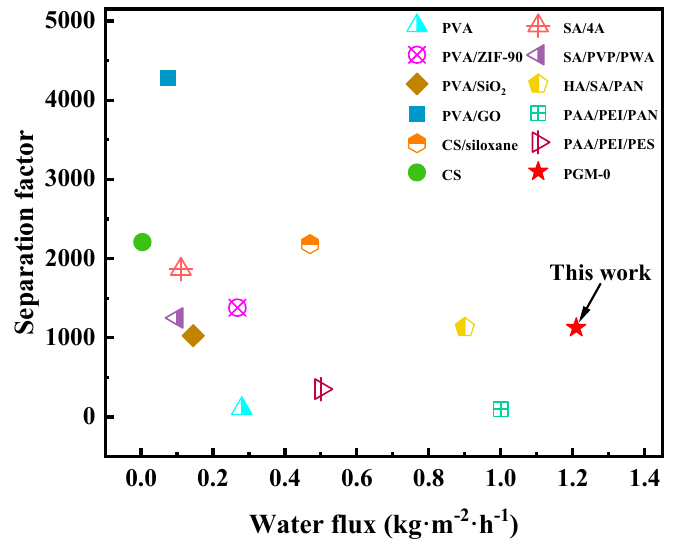
Figure 12. Comparison of the PV in this study with others.